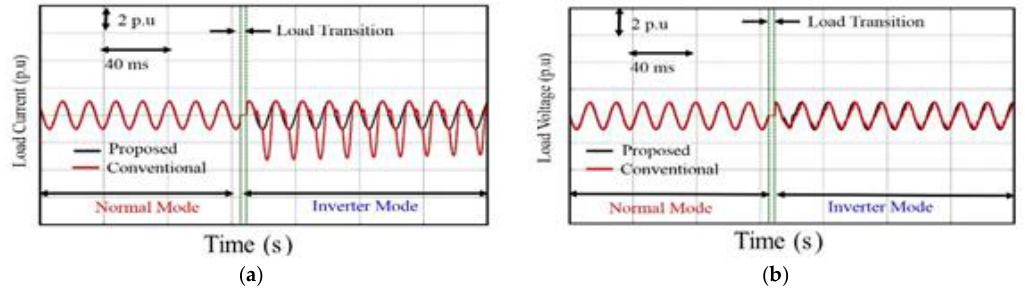
Figure 14. ( a ) Load current; and ( b ) load voltage for the conventional and proposed single-phase offline UPS topologies when the inverter voltage is injected at 60°.